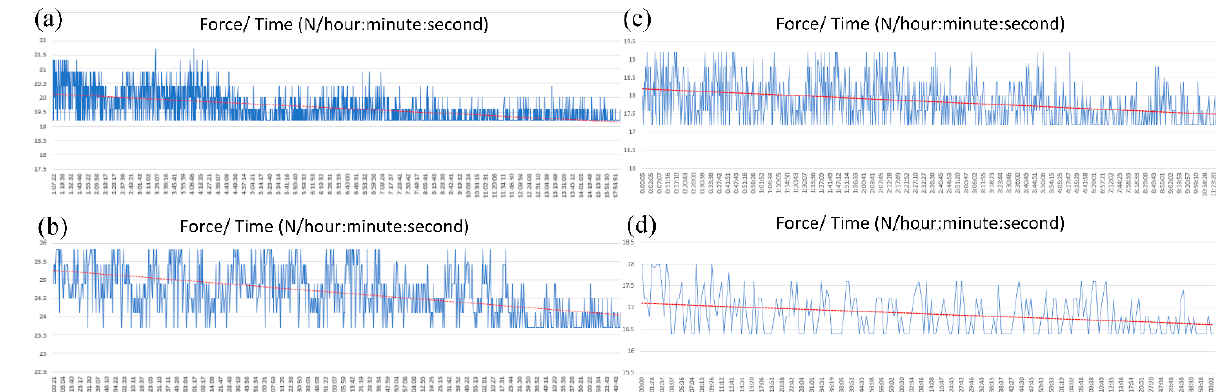
Figure 5. Fatigue diagrams of fatigue samples: sample 1.1 ( a ), sample 6.1 ( b ), sample 11.1 ( c ), and sample 16.1 ( d ). Table 2. The fatigue cycle of PP samples with different amplitudes and 1 Hz